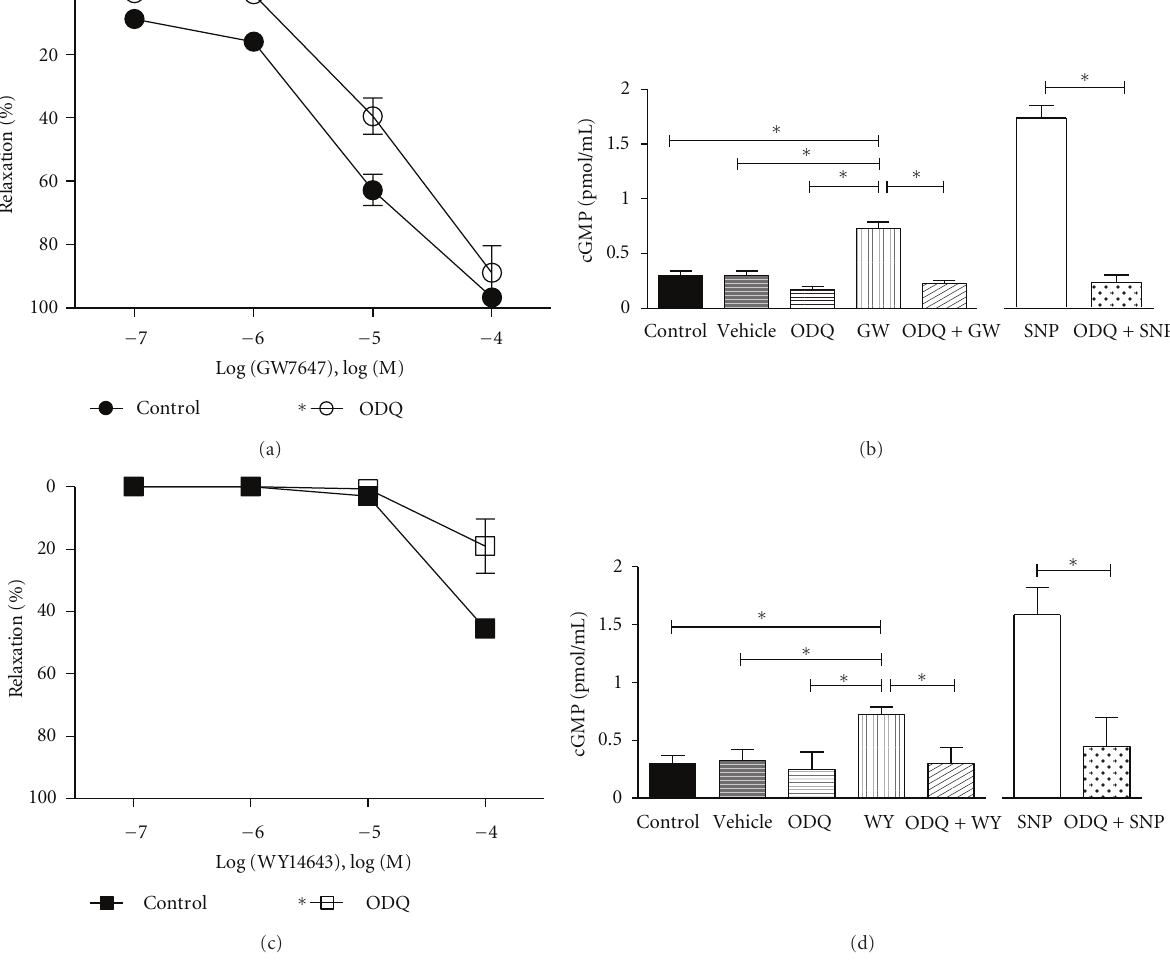
Figure 4: Involvement of sGC in PPAR α agonist mediated relaxations. E ff ect of sGC inhibitor 10 − 5 M ODQ pretreatment on GW7647 (a) and WY14643 (c) mediated relaxations ( n = 3–5). Preincubation with ODQ resulted in a rightward shift in the GW7647 and WY14643 relaxation curves demonstrating the involvement of sGC. Using an EIA kit, cGMP levels were measured in aortic rings freshly isolated from WT mice under basal and stimulated conditions. (b) 10 − 5 M GW7647 (GW) elevated cGMP content in aortic homogenates 2.4-fold over basal levels, an e ff ect that was inhibitable by pretreatment with the sGC inhibitor 10 − 5 M ODQ ( n = 4). The NO • donor 10 − 6 M sodium nitroprusside (SNP) elevated cGMP by 5.5-fold in ODQ sensitive manner ( n = 4). (d) Similar to GW, 10 − 4 M WY14643 (WY) also elevated cGMP by 2.4-fold and ODQ was able to attenuate this response to basal levels ( n = 4). Compared to untreated control conditions, vehicle treatment (DMSO for GW and WY) did not alter basal cGMP levels. Data are means ± SEM. ∗ Indicates P ≤ 0.05.